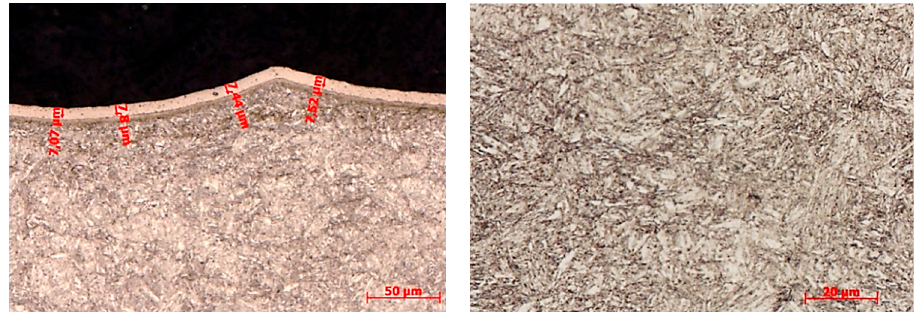
Figure 12. Sample electroless nickel-plated, turned with a feed of f 1 = 0.24 mm—surface with marked layer thickness—magnified 200× ( left ); sample center—magnified 500× ( right ).